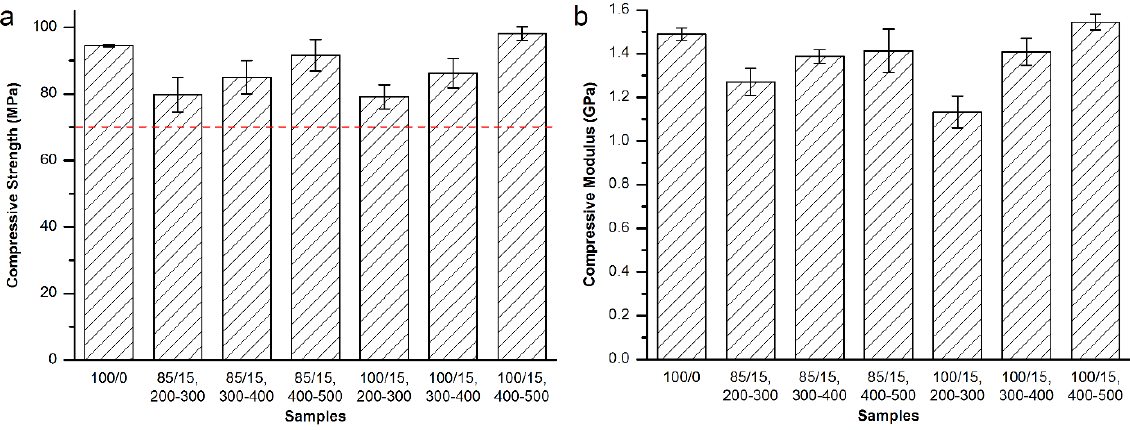
Figure 5. ( a ) Compressive strength and ( b ) compressive modulus of the MC modified Mendec ® Spine bone